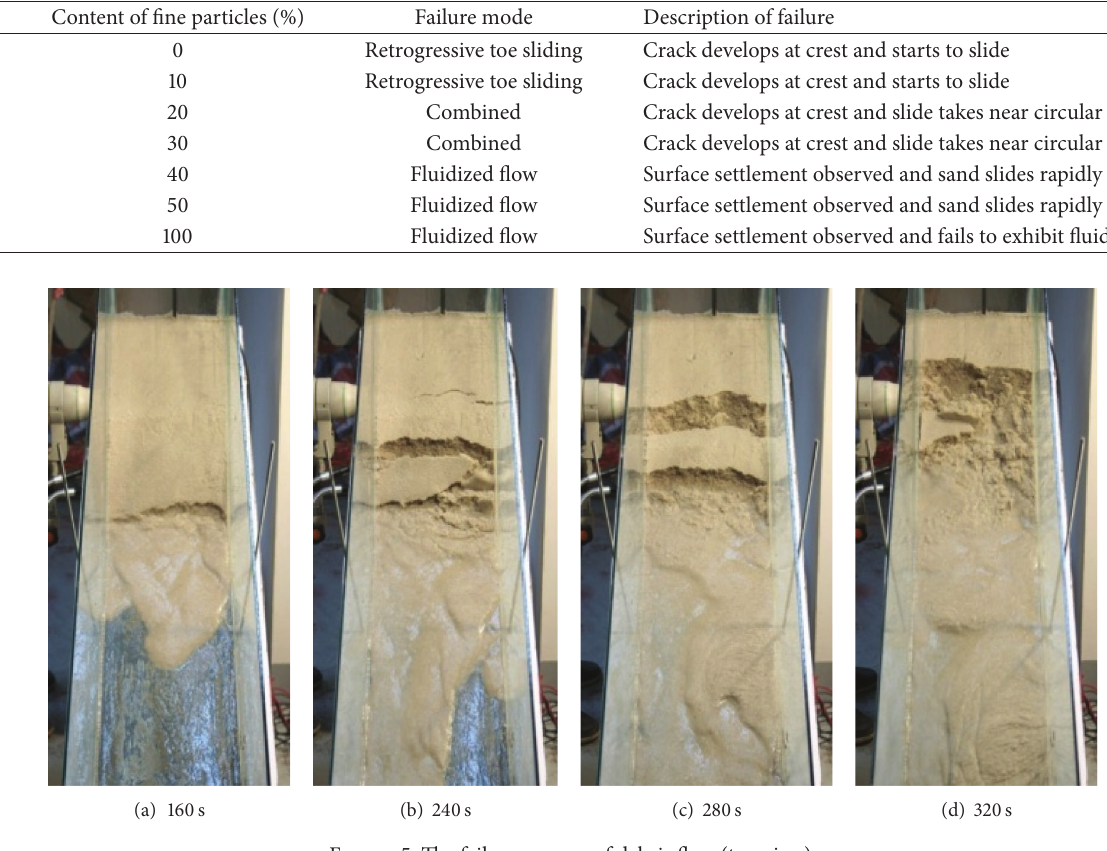
Figure 5: The failure process of debris flow (top view).